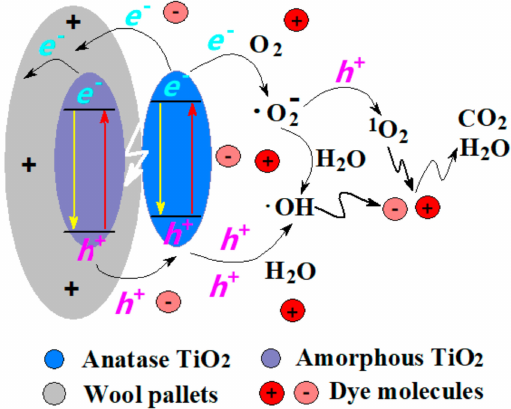
Figure 7. Reaction mechanism of the WT powders on the photodegradation of MB dye solutions under visible light